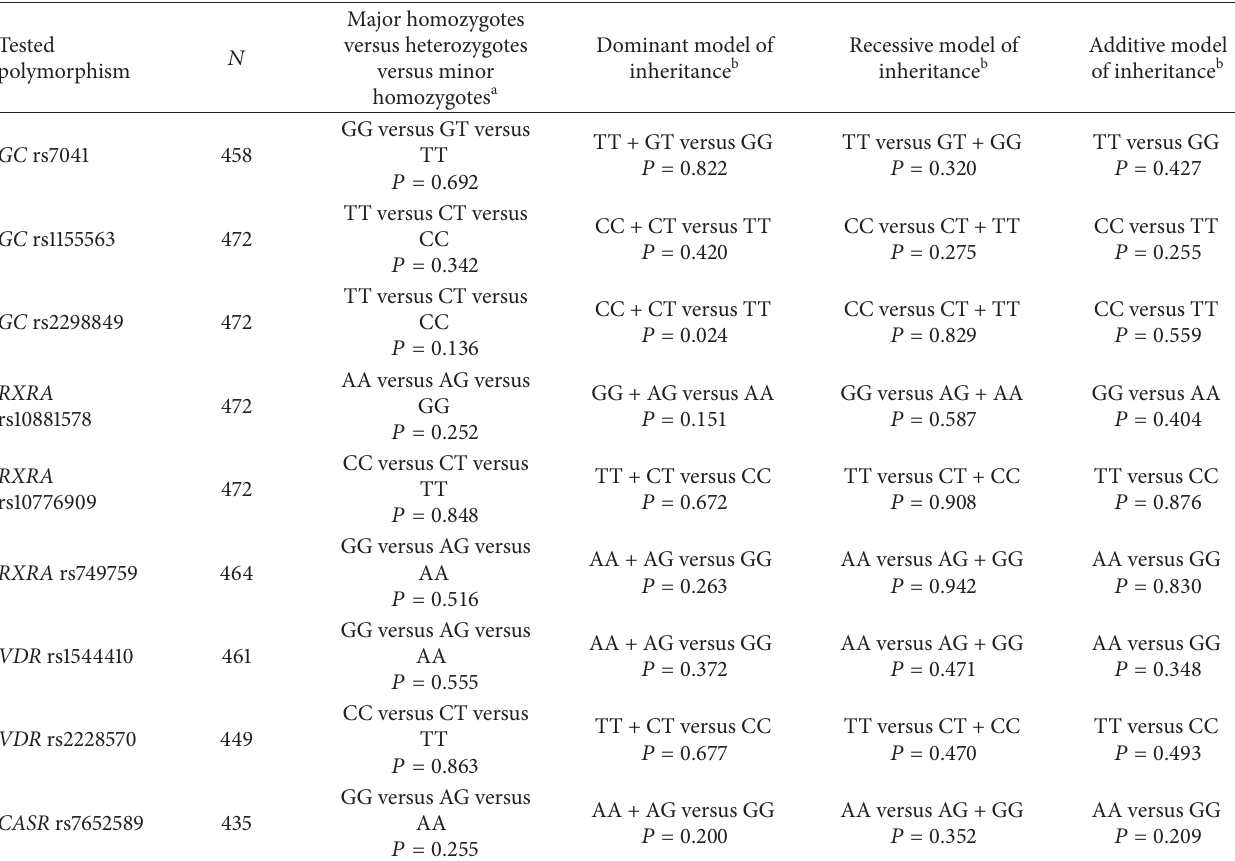
Table 3: Statistical significance of differences in all-cause mortality evaluated by the Kaplan-Meier analysis for vitamin D signaling pathway genes and CASR in hemodialysis patients undergoing the 7-year prospective